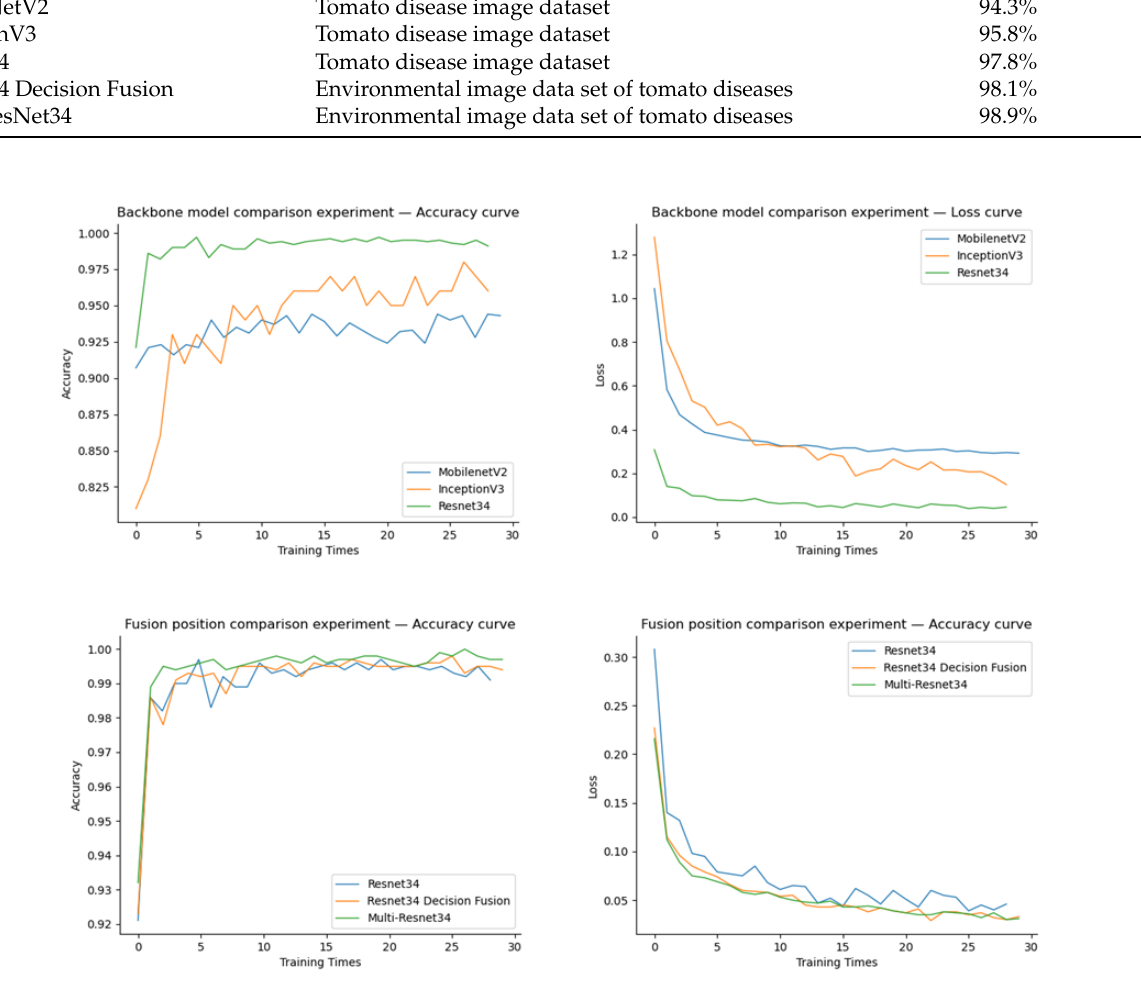
Figure 8. The training process of different models on the tomato disease dataset.